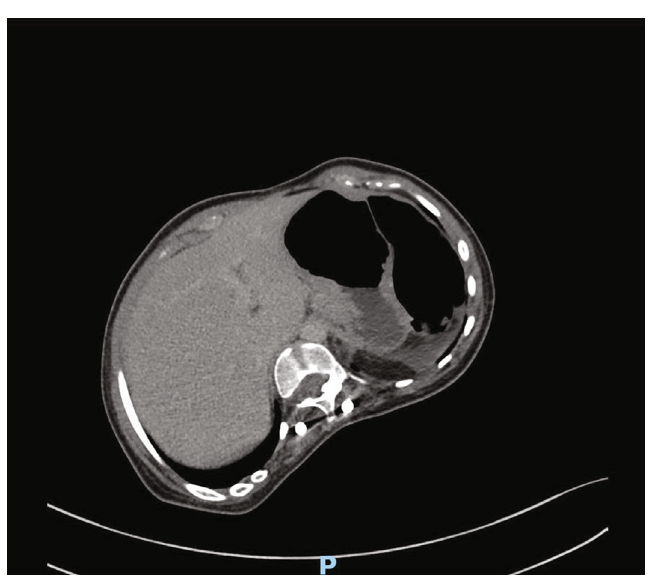
Figure 2: Absence of the spleen in the left